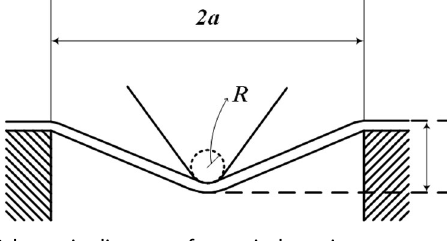
Fig. 10 Schematic diagram of